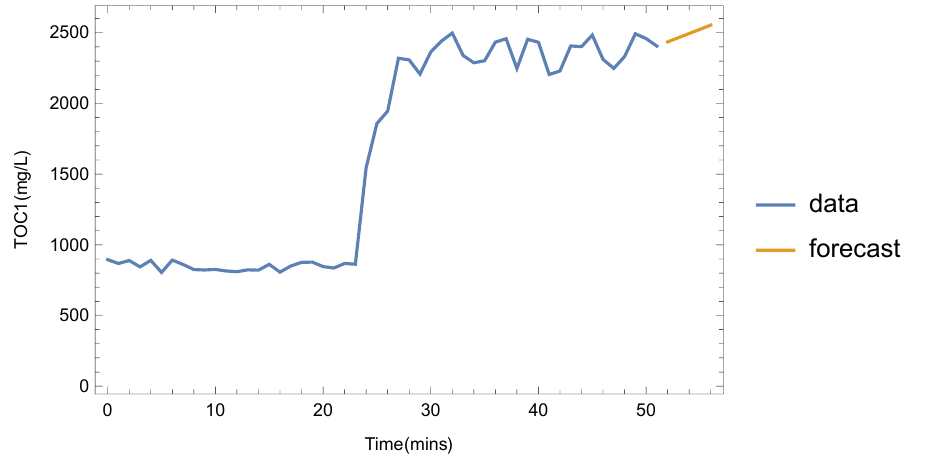
Figure 6. Forecasting the T0C 1 values using single-variable method (data points are separated by 1 min intervals).